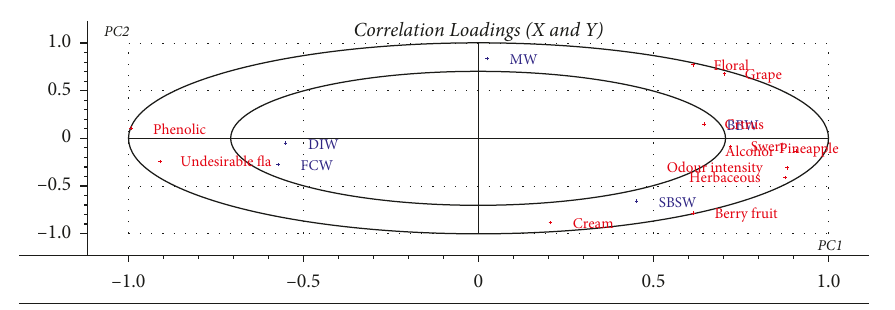
Figure 1: PLS regression map showing the five home-brewed wines correlated with 11 odor descriptors analyzed by seven sensory